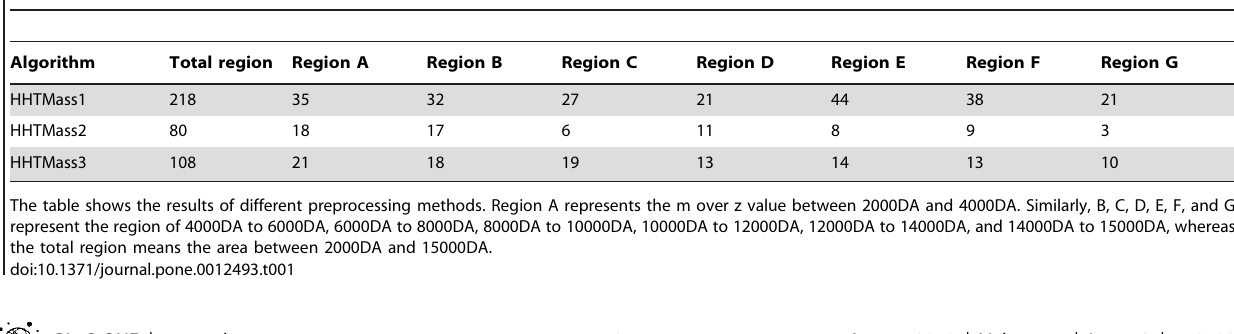
Figure 5. Spectrum data after using HHT preprocessing. The data after using Hilbert Huang transformation without modification. The high frequency noises are removed. doi:10.1371/journal.pone.0012493.g005 Table 1. The amount of the peaks detected in our three